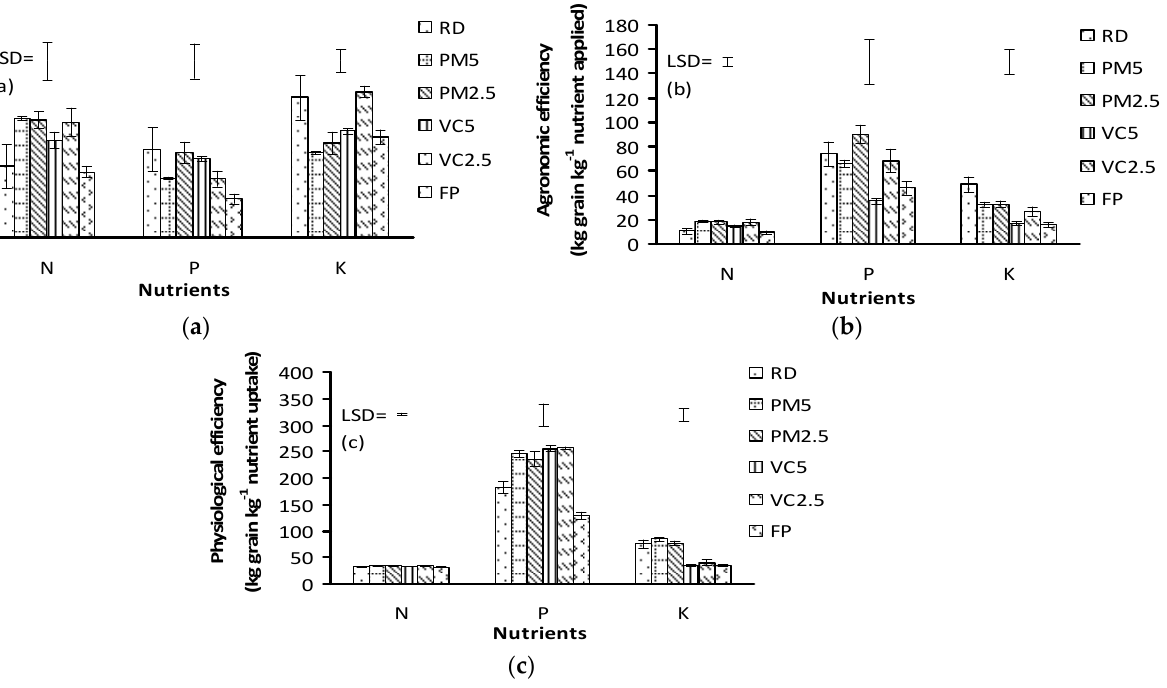
Figure 3. Nutrient use efficiencies ( a ) recovery efficiencies, ( b ) agronomic efficiencies, and ( c ) physiological efficiencies in the integrated nutrient management of organic and inorganic fertilizers in rice. Note: RD = recommended inorganic fertilizers; PM = poultry manure; VC = vermicompost; FP = farmer’s practice.